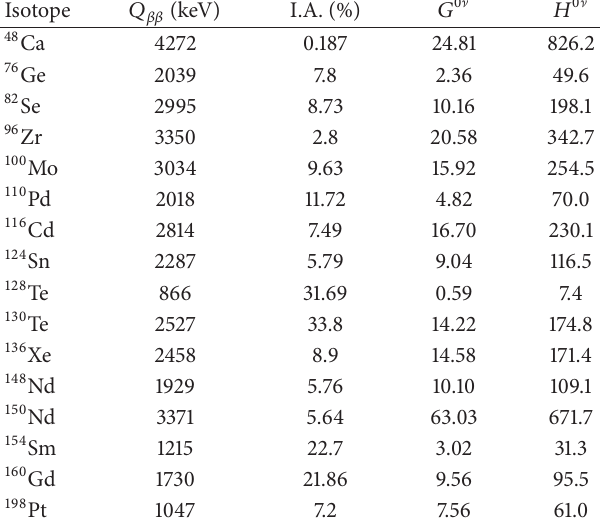
Table 3: Phase-space factors 𝐺 0 ] in units of 10 −15 yr − 1 [38]